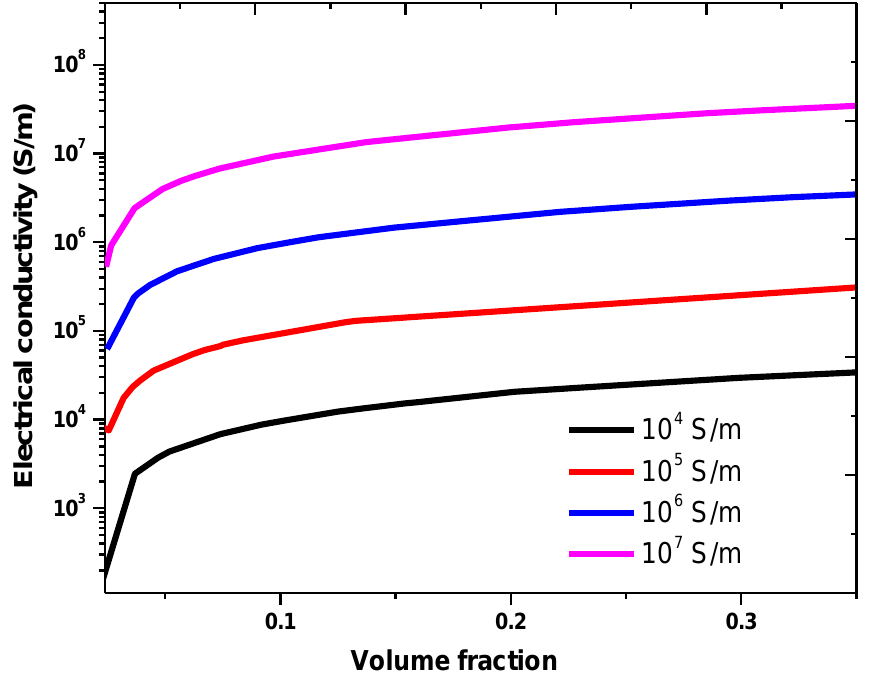
Figure 8. Electrical conductivity of the graphene–PPy composite for different graphene volume fractions and dc electrical conductivities.